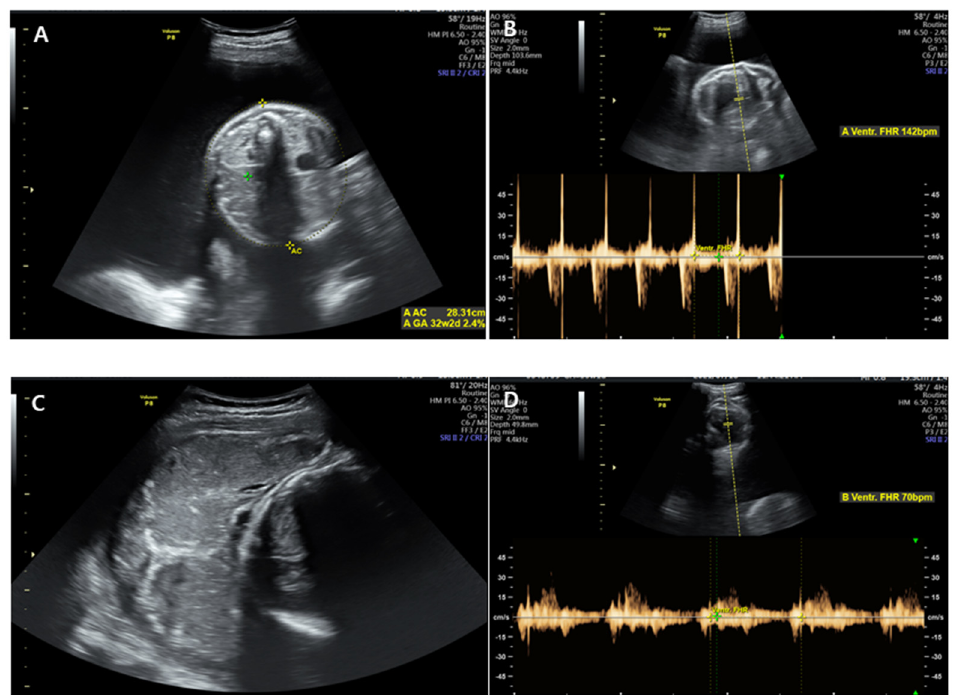
Figure 2. Ultrasonography was performed at admission. ( A , B ) showed the first fetus located on the left side of the mother. The fetal heart rate was 140–160 beats/min with good fetal motion, and amniotic fluid volume index (AFI) was more than 30 cm, showing polyhydramnios. ( C , D ) showed the second fetus located on the right side of the mother with breech presentation. The heart rate was 70–80 beats/min, showing a consistent bradycardia.